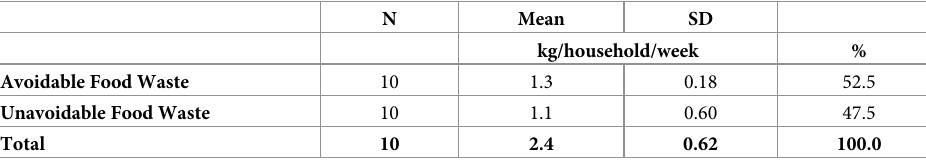
Table 5. Avoidable and unavoidable food waste